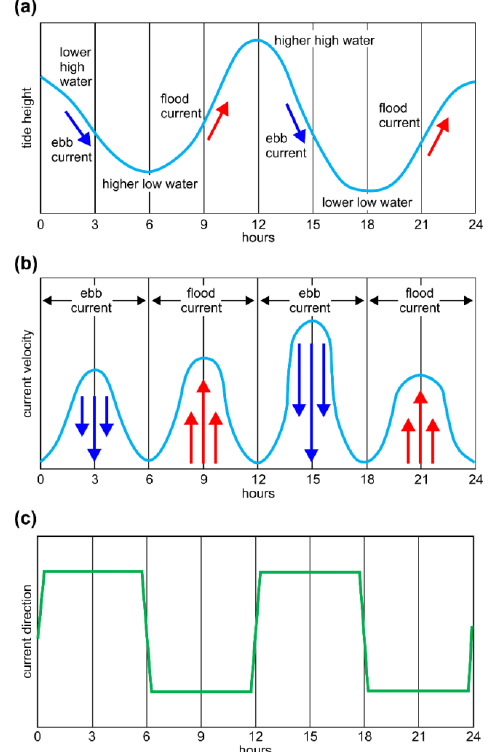
Figure 2. General relationship and alteration between tide and tidal streams: ( a ) general tidal movement; ( b ) change in current velocity; ( c ) change in current